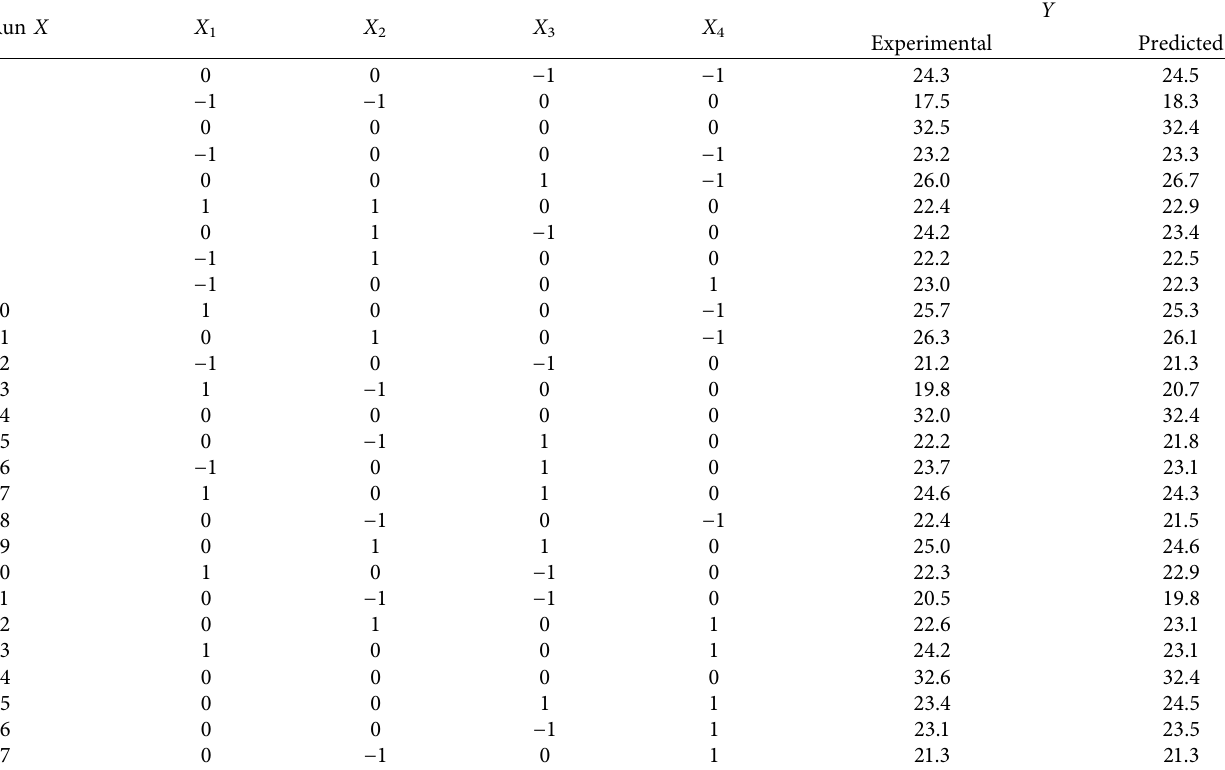
Table 2: Factors and levels for RSM, and Box–Behnken design with the independent